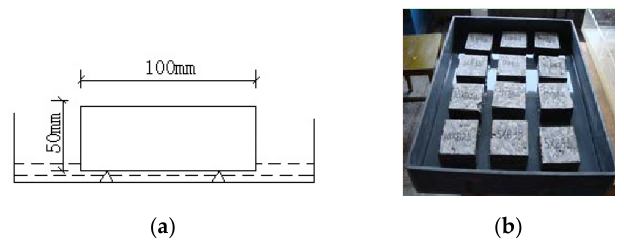
Figure 1. ( a ) Schematic of concrete capillary absorption test; ( b ) Concrete capillary absorption test.